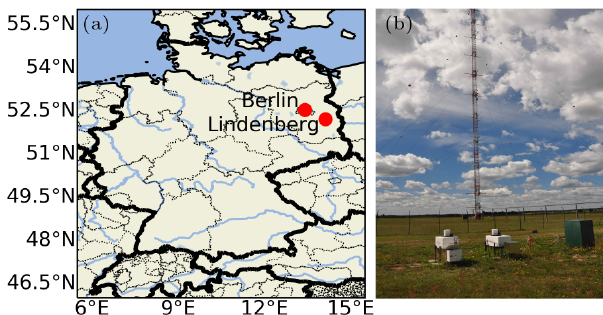
Figure 1. Measurement site. (a) The MOL-RAO is situated in the northeastern part of Germany, approximately 65km southeast of Berlin. (b) Two Doppler wind lidars in front of Falkenberg mete- orological tower (27 July 2020, author’s photo); Falkenberg is ap- proximately 5km south of